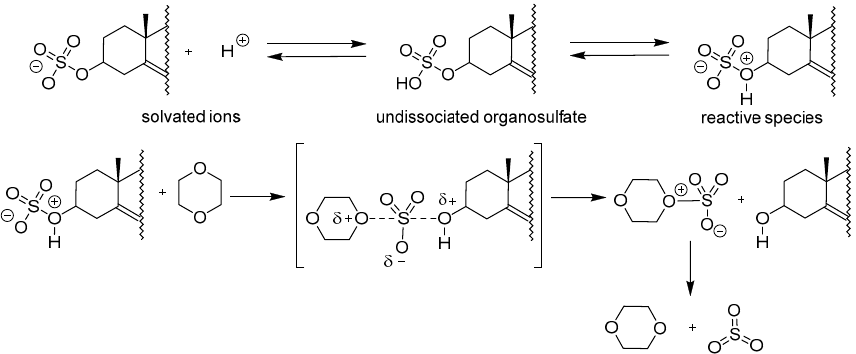
Scheme 3. Mechanism of the acid-catalyzed solvolysis of sterol sulfates in 1,4-dioxane, as proposed by Burstein and Lieberman [55]. Molecules 2019 , 24